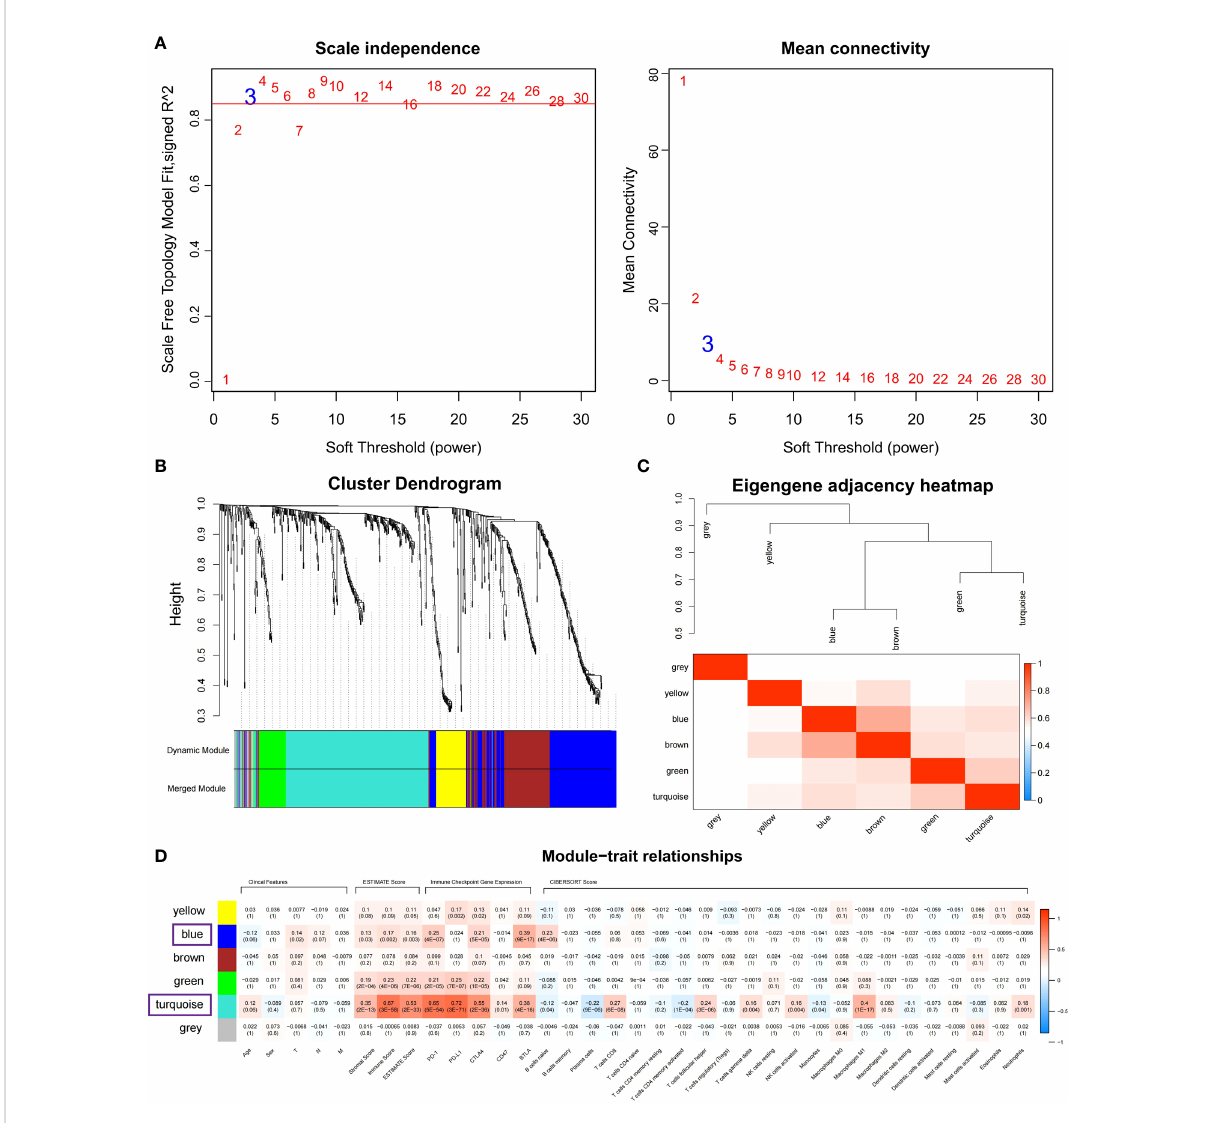
FIGURE 4 Identifying immune-related modules by WGCNA. (A) The scale-free fi t index analysis and the mean connectivity for various soft-thresholding powers ( b ). (B) Dendrogram for clustering all differentially expressed genes relies on a measure of dissimilarity (1-TOM). (C) Clustering correlations among WGCNA modules. The color red represents a positive correlation, and blue represents a negative correlation. (D) Heatmap revealing the relationship between modules, clinical features, and immune factors, including ESTIMATE score, the immune checkpoints expression, and CIBERSORT 22 immune cell score. The red refers to a positive correlation, while the blue indicates a negative